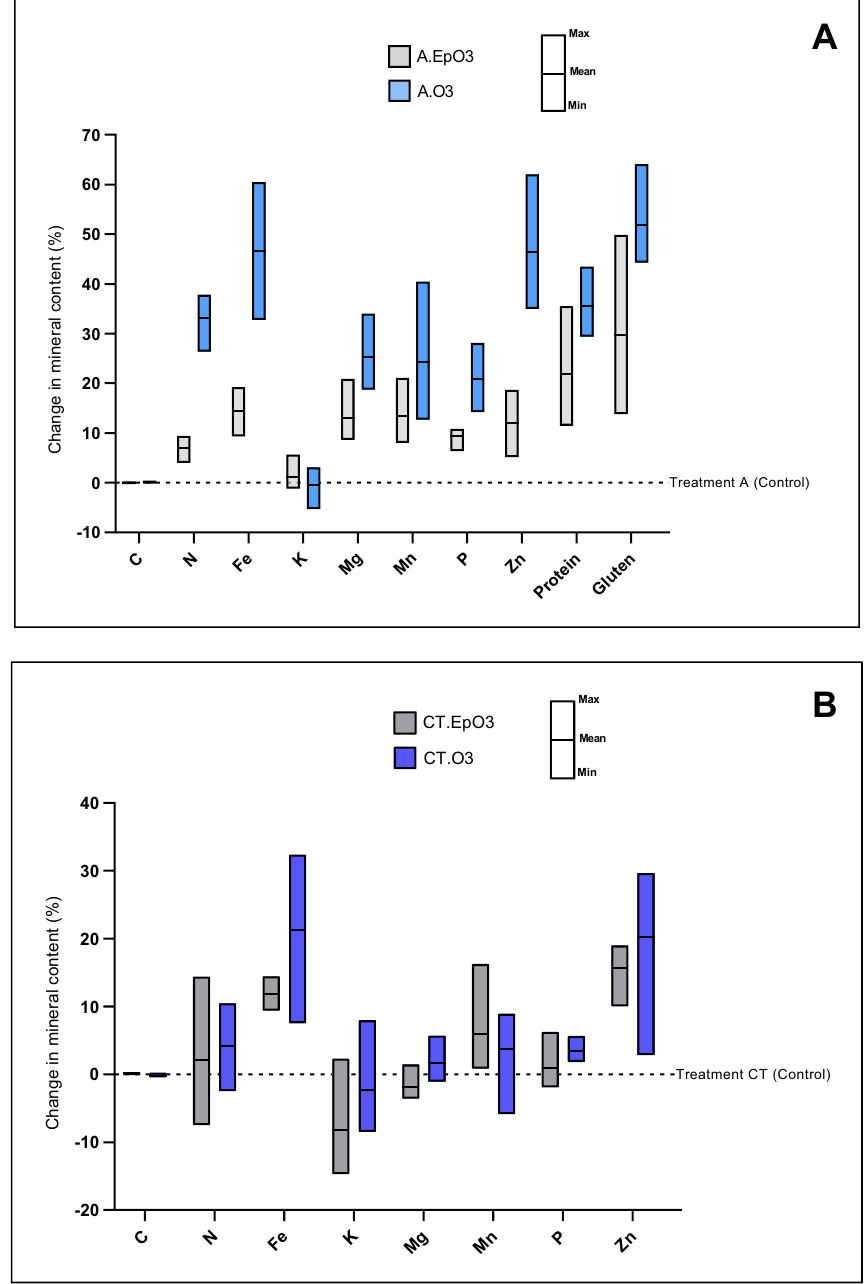
Figure 2. Change of mineral content of three European wheat varieties under effect of ozone alone ( A ) and combined with high CO 2 and elevated temperature ( B ). A = Ambient CO 2 , lower temperature settings and no O 3 addition (control). A.EpO3 = Ambient CO 2 , lower temperature settings and episodic O 3 addition. A.O3 = Ambient CO 2 , lower temperature settings and chronic O 3 addition. CT = High CO 2 , higher temperature settings, and no O 3 addition. CT.EpO3 = High CO 2 , higher temperature settings and episodic O 3 addition. CT.O3 = High CO 2 , higher temperature settings and chronic O 3